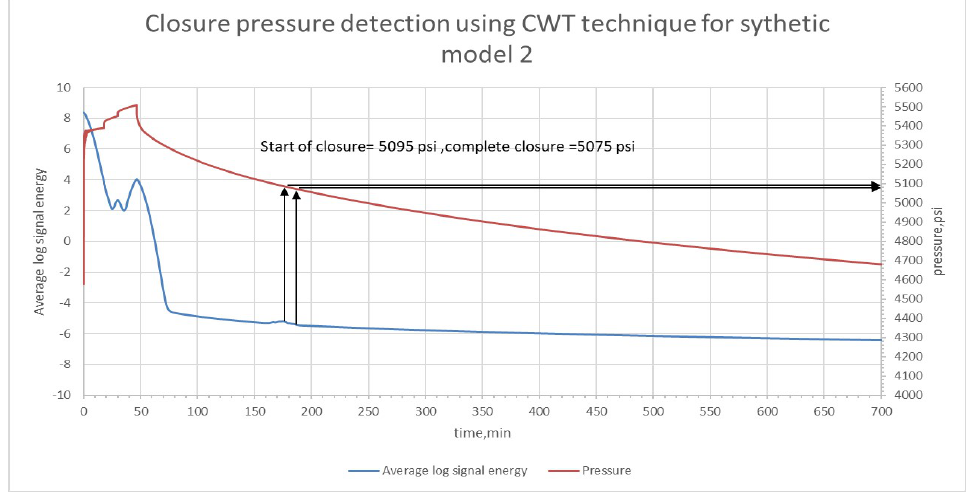
Figure 14. Signal average log energy using CWT for synthetic model